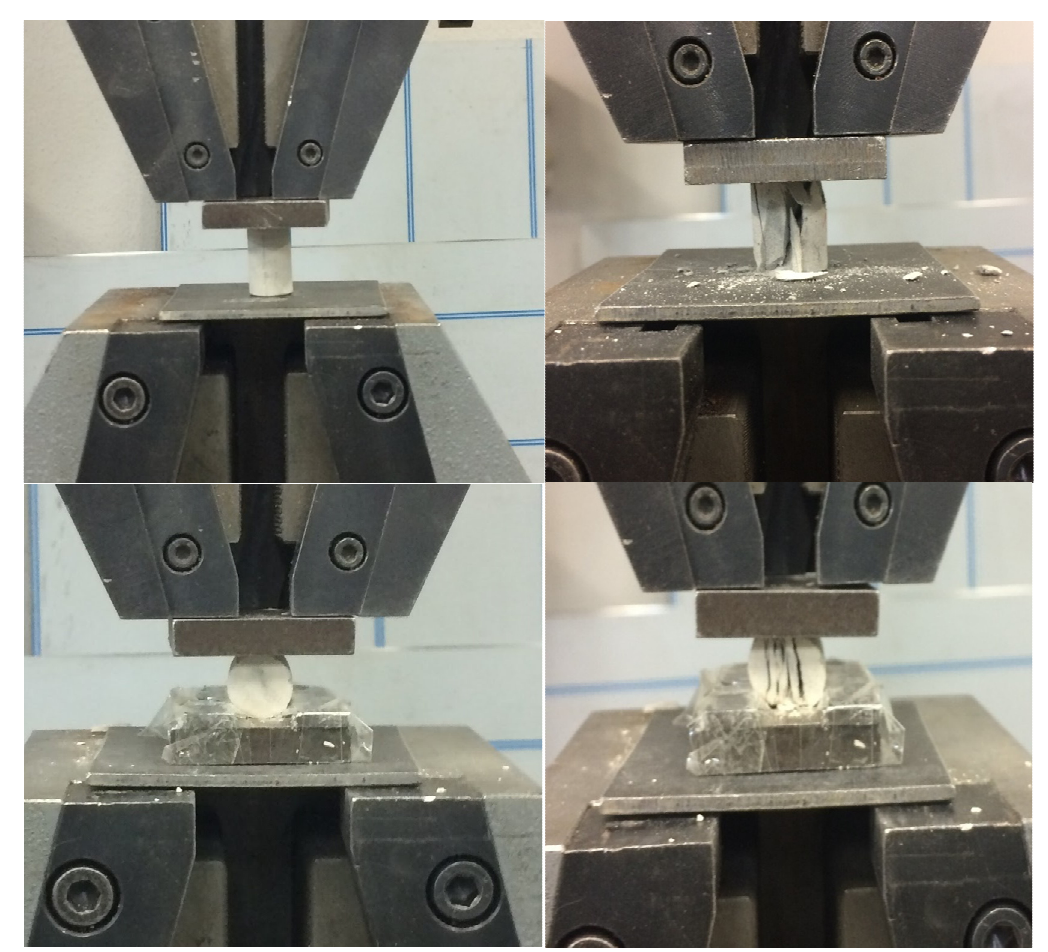
Figure 3. ( upper) Compressive strength test; ( lower ) indirect tensile strength test. Figure 3. ( upper ) Compressive strength test; ( lower ) indirect tensile strength